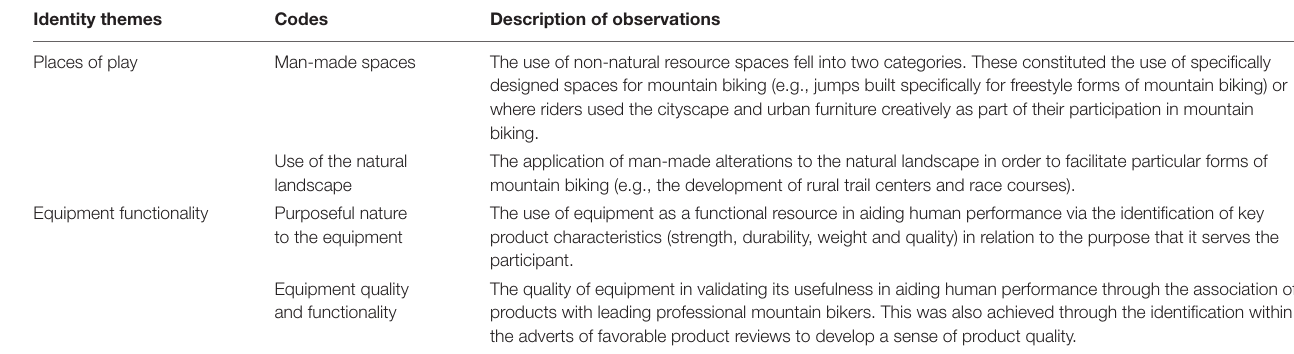
TABLE 1 | The two core identity characteristic themes associated with all mountain